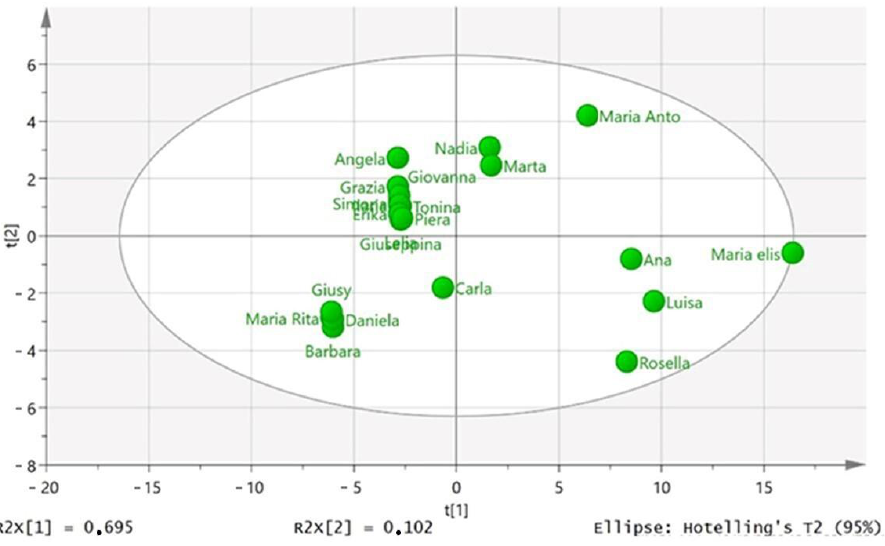
Figure 5. Principal component analysis using climatic data site of origin of cultivars and total phenols, anthocyanins, and tannins content of berries.